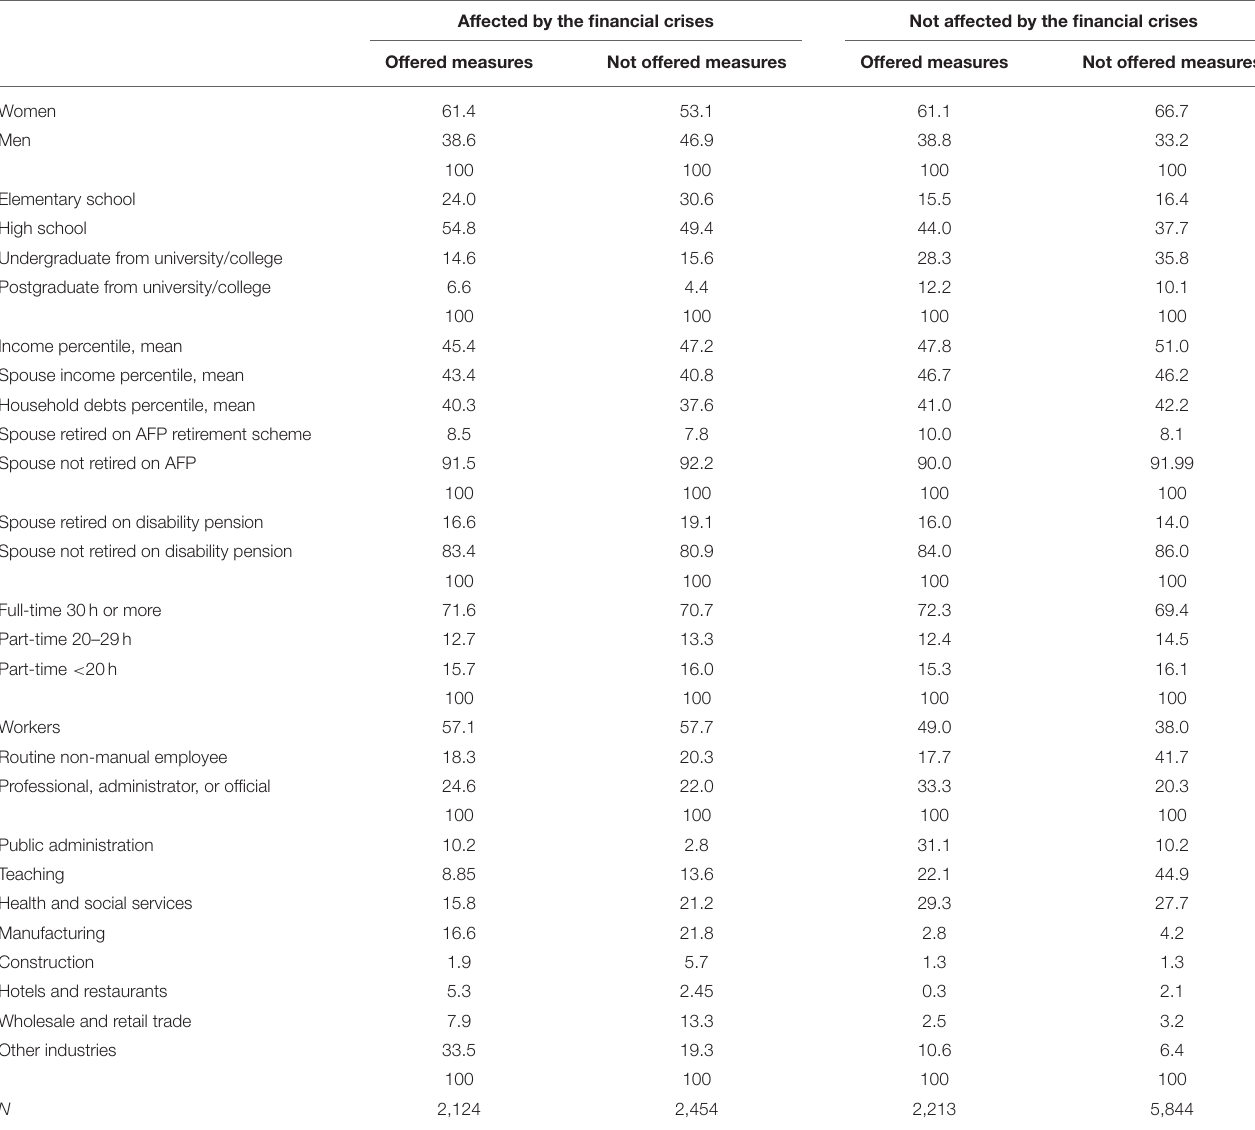
TABLE 1 | Descriptive statistics—control variables and key information for the group of 61-year-olds depending on the measure exposure (all sort of retention measures) and whether work in companies affected and not affected by the financial